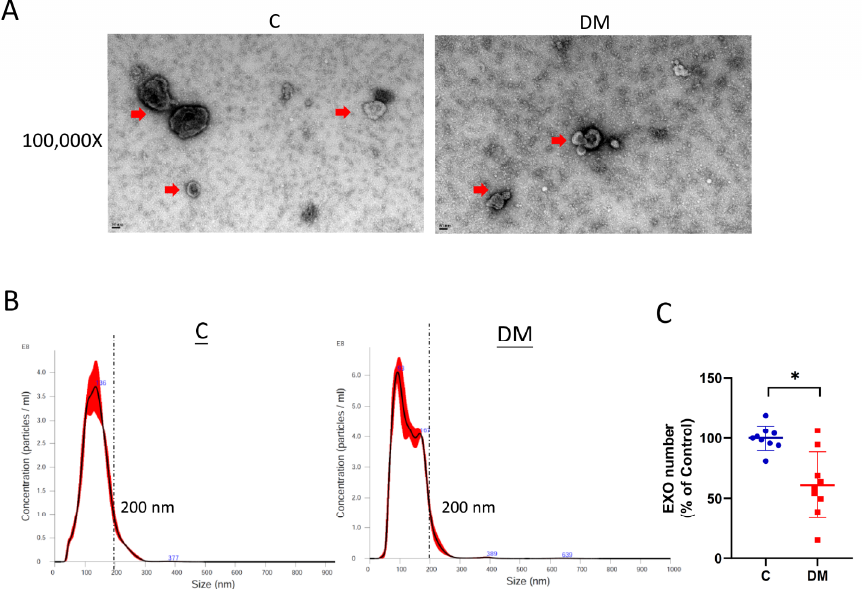
Figure 6. Characterization of plasma EXO in control and DM rats. ( A ) Photographs of EXO taken using transmission electron microscopy (TEM). EXO is shown at a magnification of 100,000X (scale bar = 50 nm). The red arrow indicates the isolated EXO. ( B ) Size-concentration distribution of EXO. ( C ) Reduced number of EXO in T1DM rats. Data are expressed as mean ± SEM ( n = 9). p -values were determined by Student’s t -test. * p < 0.05 DM vs. C.